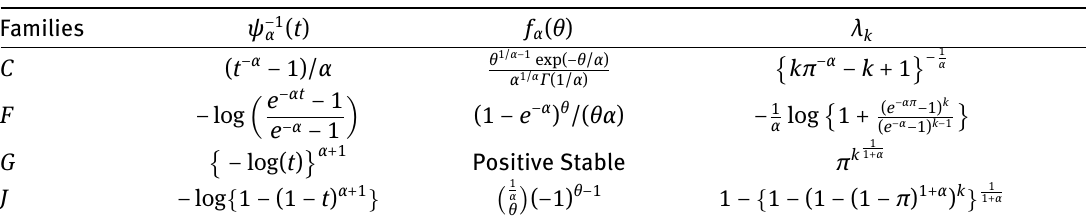
Table 1: Inverse of Laplace transforms, the densities of the random effects θ i , and moments for four copula families, Clayton (C), Frank (F), Gumbel (G), Joe